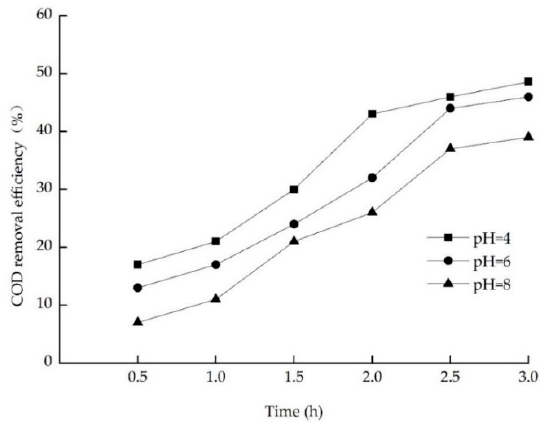
Figure 5. Effect of pH on COD removal.